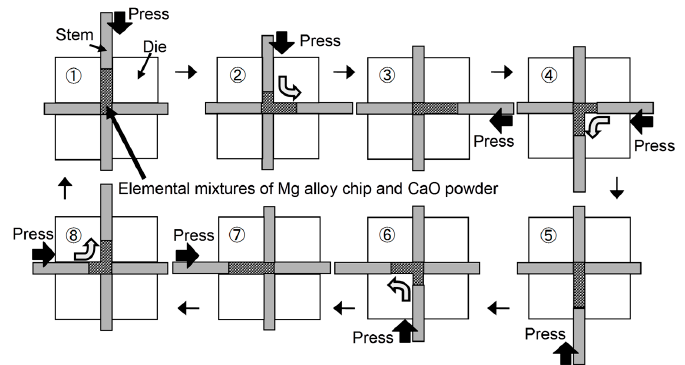
Figure 3. Schematic illustration of one cycle of equal channel angular bulk mechanical alloying (ECABMA) process used in fabrication of Mg alloy powder precursor containing CaO particles.